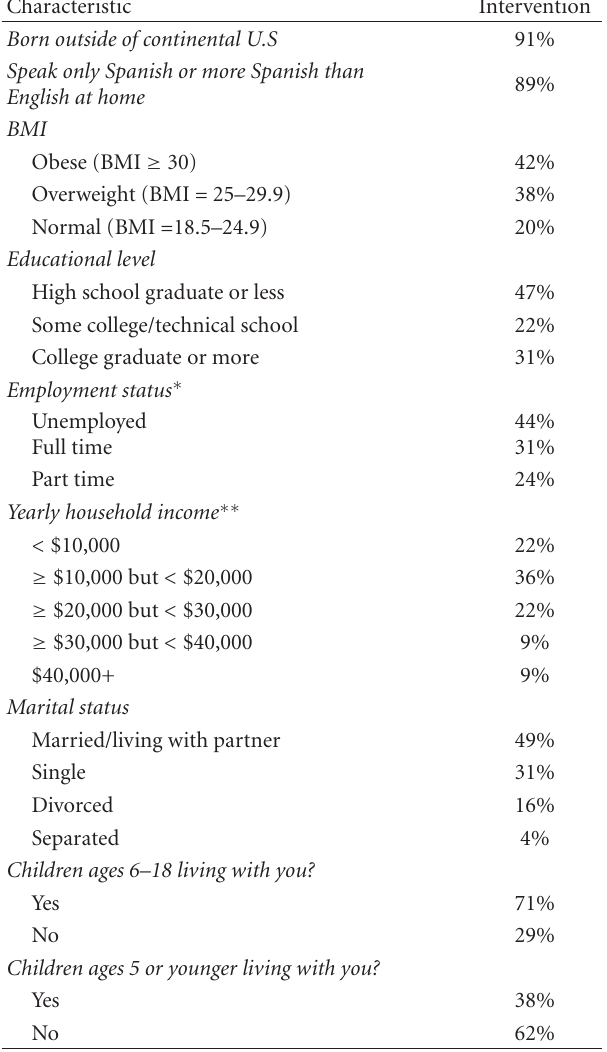
Table 1: Demographic characteristics ( N =